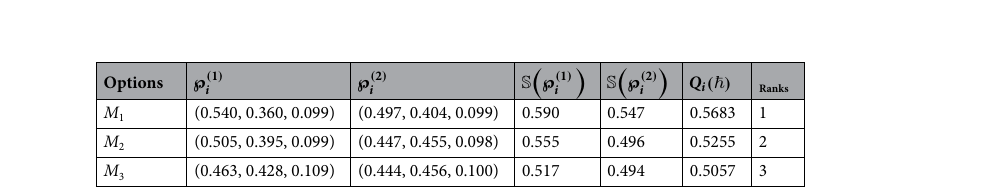
Table 15. The IF-WASPAS method for prioritizing